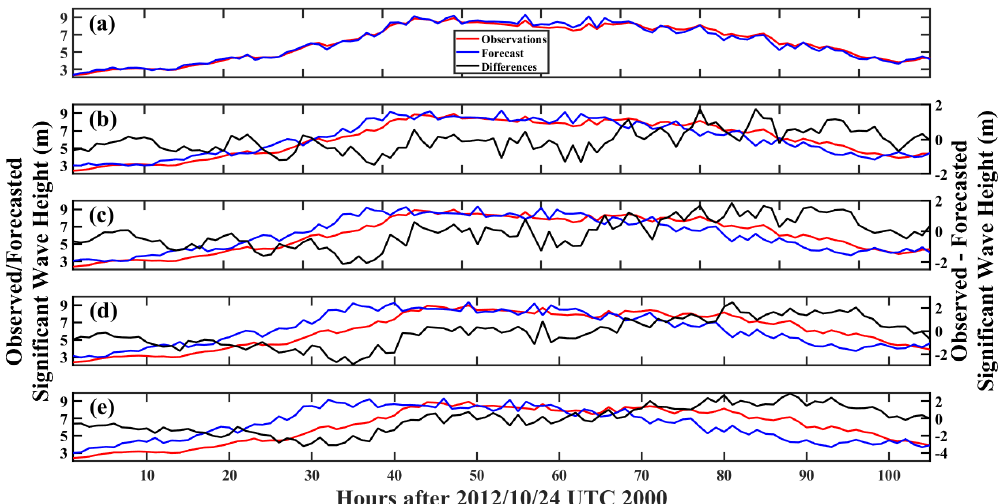
Figure 4. Same as Fig. 3, but for Hurricane Sandy (2012) measured at buoy